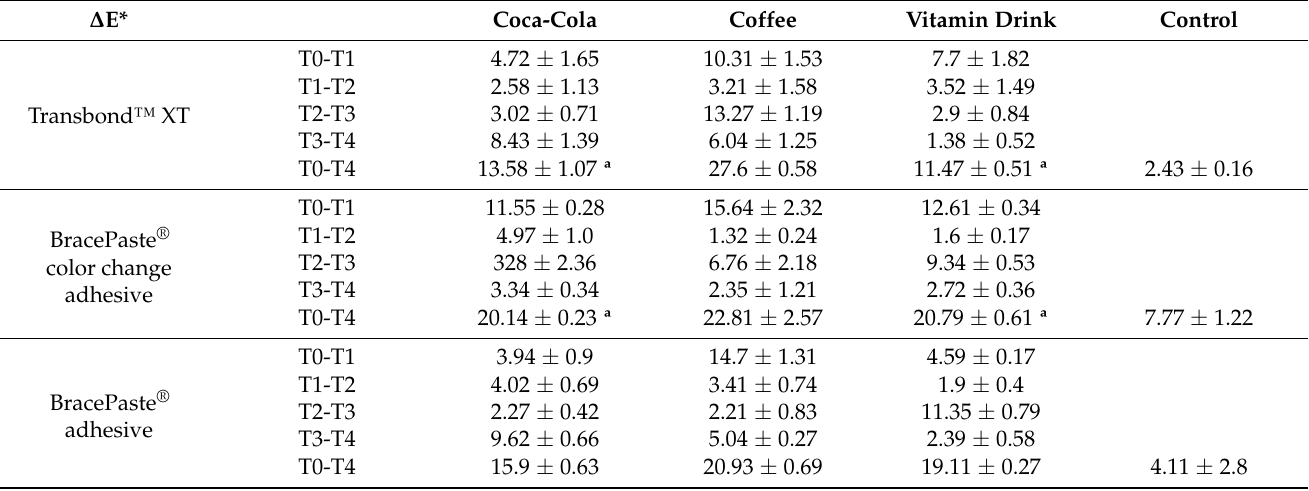
Table 3. Means and standard deviations of color change values ( ∆ E*) of adhesive samples, according to the solution over time.